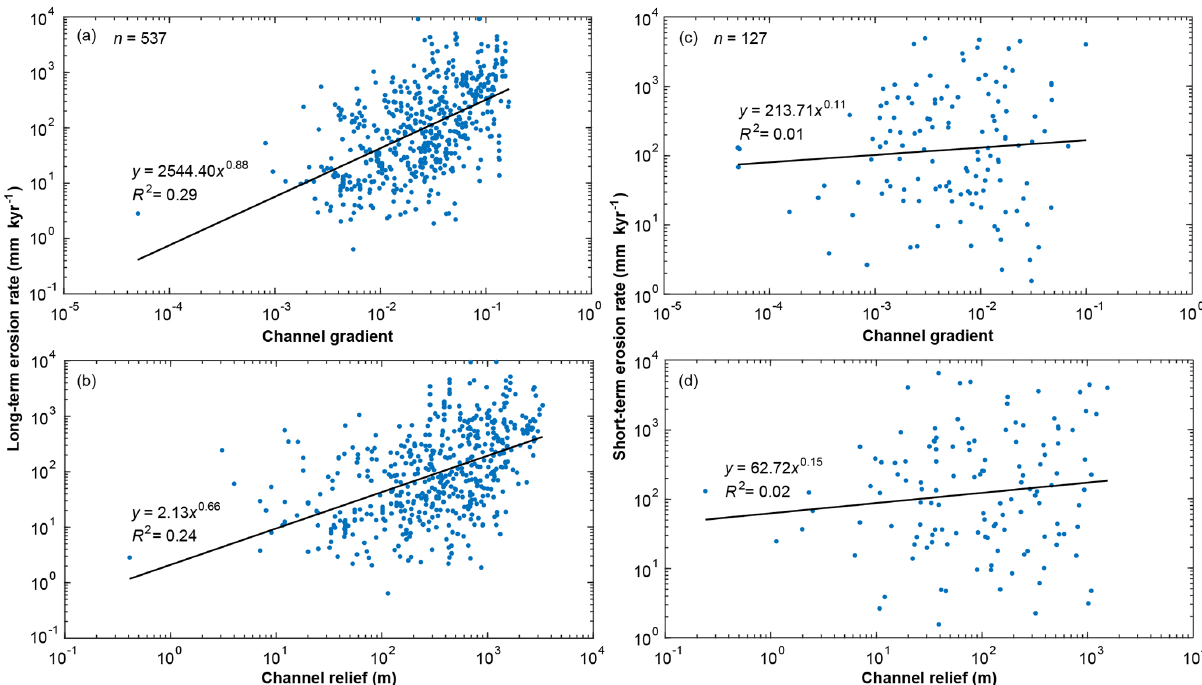
Figure 10. Relationships between topographic parameters of river longitudinal profiles and long- (a, b) and short-term (c, d) erosion